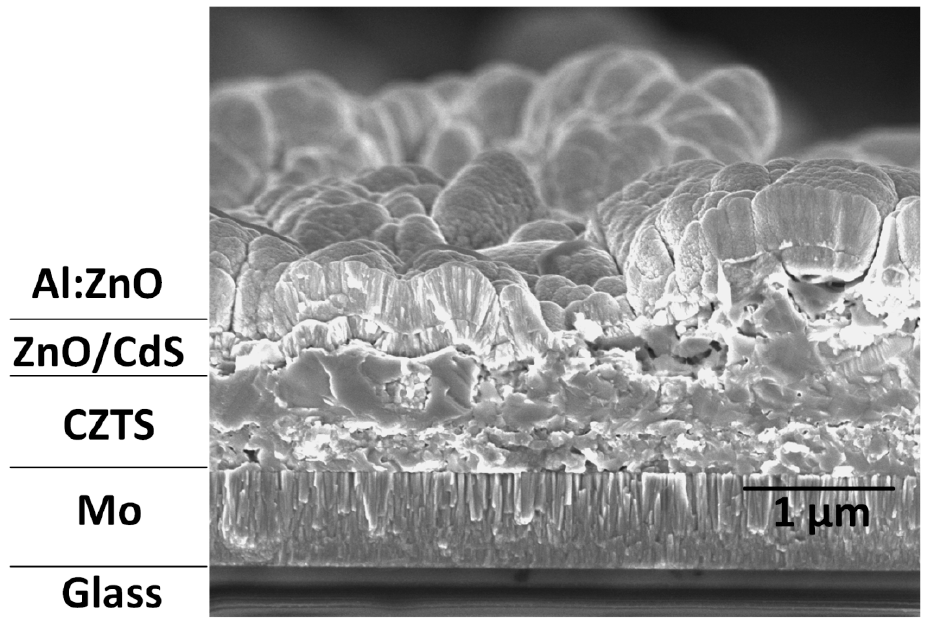
Figure 9. Field-emission scanning electron microscopy of the cross-section for the soda-lime glass (SLG)/Cu 2 ZnSnS 4 (CZTS)/CdS/i-ZnO/aluminum-doped zinc oxide (AZO) photovoltaic device based on the sample DIO-20 mg/mL.